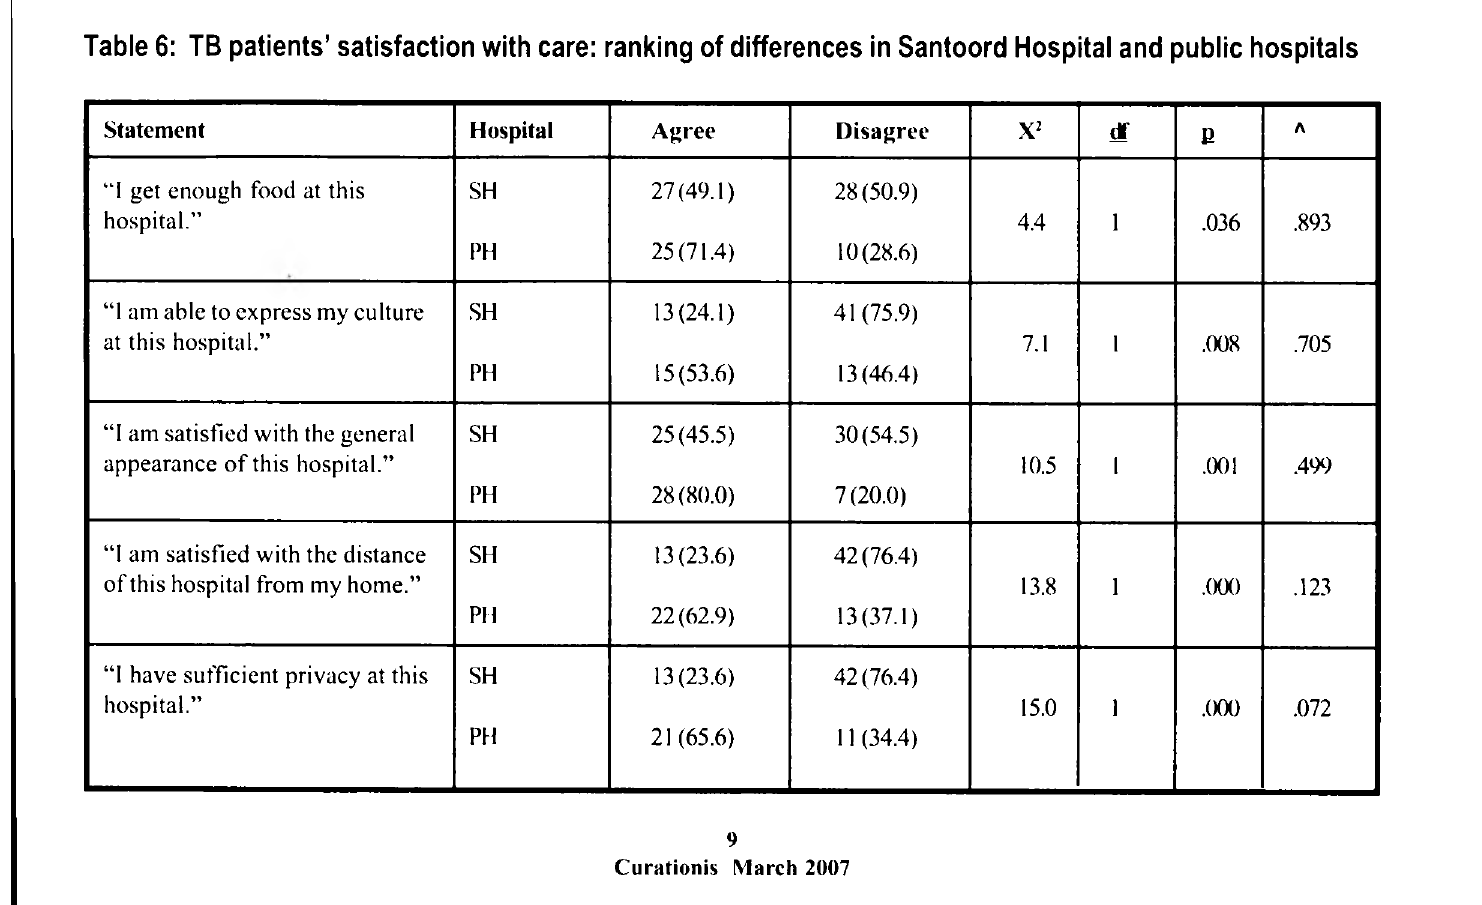
Table 6: TB patients’ satisfaction with care: ranking of differences in Santoord Hospital and public